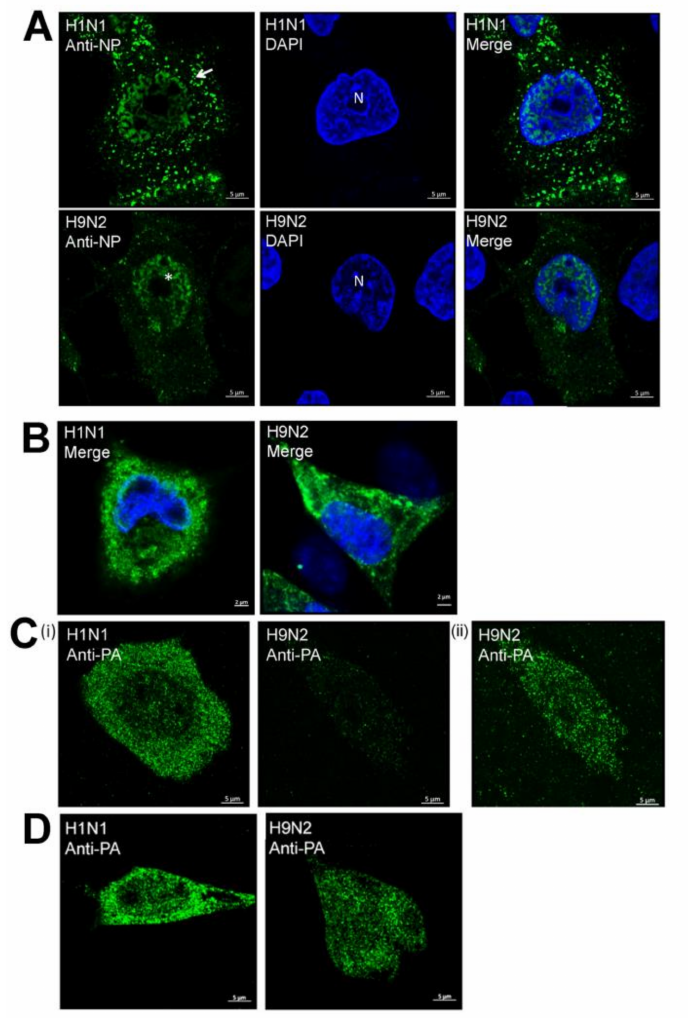
Figure 3. Analysis of the distribution of the NP and PA protein in H1N1 / WSN, and H9N2 influenza virus-infected A549 and CEF cells. At 20 h post-infection (hpi) ( A ) A549 and ( B ) CEF cells infected with H1N1 and H9N2 viruses were co-stained using DAPI (blue) and anti-NP (green) and examined using confocal microscopy. The location ofthe nucleus (N), cytoplasmicNP staining inthe H1N1 virus-infected cells (white arrow) and enhanced nuclear NP staining in H9N2 virus-infected cells (*) are highlighted. ( C ) A549 and ( D ) CEF cells infected with H1N1 and H9N2 viruses were co-stained using anti-PA (green) at 20 hpi and examined using confocal microscopy. In each plate, representative cells are shown, and in each cell and antibody staining combination identical machine settings were used. In ( C (ii)) the same cell as in ( C (i)) is viewed using higher laser energy to view the PA staining